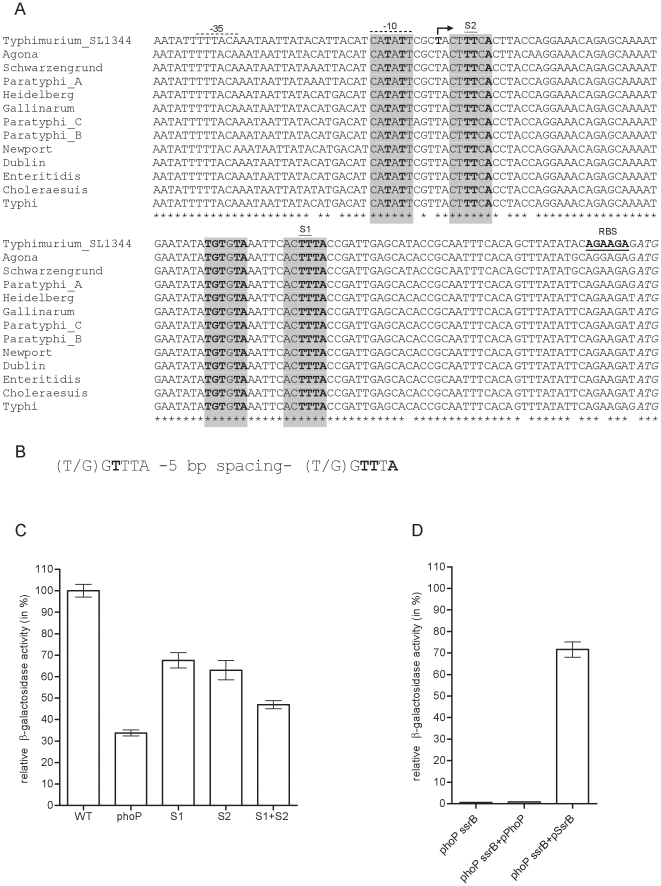
The regulatory region of sseL is highly conserved and possesses two putative PhoP binding sites.(A) Sequence alignment of 137-bp upstream from the predicted start codon of SseL (GI:267994379) is shown for S. Typhimurium SL1344 (FQ312003.1); S. Agona (CP001138.1); S. Schwarzengrund (CP001127.1); S. Paratyphi A (FM200053.1); S. Heidelberg (CP001120.1); S. Gallinarum (AM933173.1); S. Paratyphi C (CP000857.1); S. Paratyphi B (CP000886.1); S. Newport (CP001113.1); S. Dublin (CP001144.1); S. Enteritidis (AM933172.1); S. Choleraesuis (AE017220.1); and S. Typhi (AE014613.1). The identified transcription start site in S. Typhimurium is indicated in bold and by the bent arrow. The predicted ribosomal binding site (RBS) is shown in bold and underlined; the predicted start codon of sseL, (ATG), is in italics; and the probable σ70 −35 and −10 elements are marked by broken upper-line. The putative PhoP binding sites are indicated by shaded boxes and the nucleotide residues that match the canonical PhoP-box are in bold. S1 and S2 indicate the two conserved thymines (in the second hexanucleotide at positions 3 and 4) that were replaced by site directed mutagenesis. (B) Nucleotide architecture of a canonical PhoP-box. Conserved positions that are necessary and sufficient for DNA binding by PhoP are marked in bold. (C) Relative expression (from the wild-type) of sseL::lacZ is shown for a wild-type promoter in S. Typhimurium (WT), a wild-type promoter in a phoP mutant background (phoP), and manipulated promoters harboring S1, S2 or S1 and S2 nucleotide substitution (from TT to GG) in the predicted PhoP binding sites (as indicated in A) in a wild-type background. (D) Relative expression (from the wild-type) of sseL::lacZ driven by a modified promoter (harboring mutation in both S1 and S2 sites) is shown in a S. Typhimurium phoP ssrB background without complementation (phoP ssrB), in the presence of S. Typhimurium PhoP (phoP ssrB+pPhoP), or SsrB (phoP ssrB+pSsrB). All S. Typhimurium cultures were grown in LPM medium to late logarithmic phase (6 h).